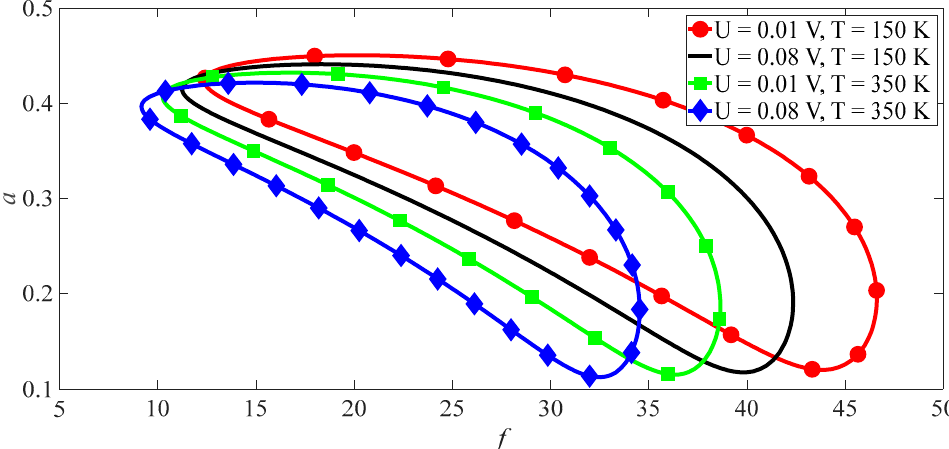
Figure 12. Effect of temperature and electric fields on the amplitude of second mode for ( c 2 , σ ) = ( 5,80 ) .